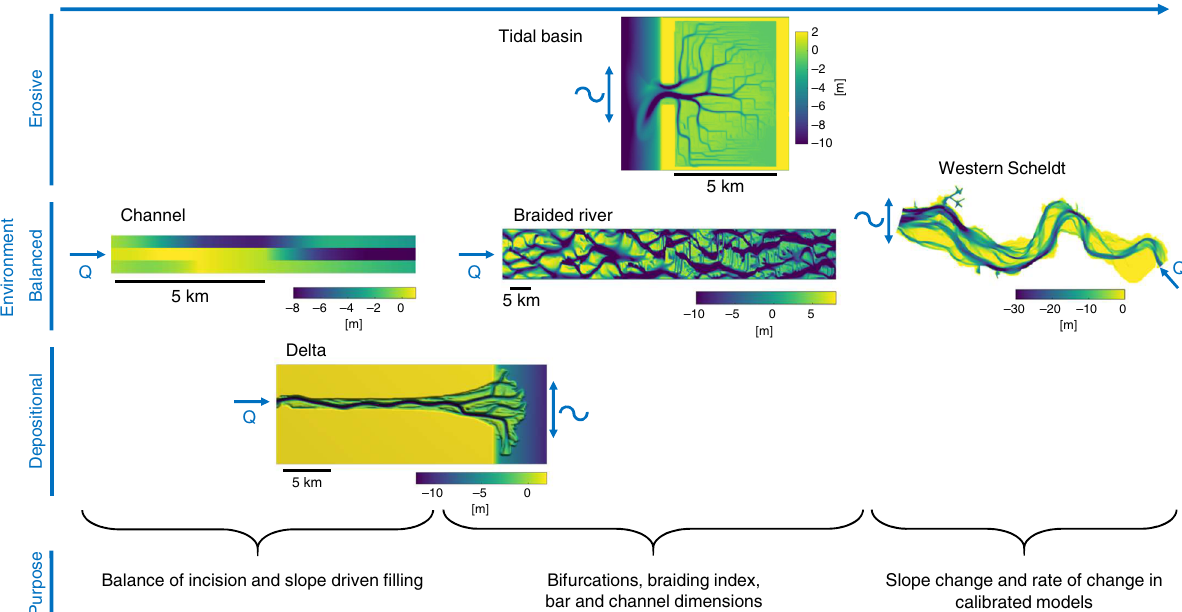
Fig. 3 Overview of model environments and objectives in this study. The narrow channel model and the river in the delta model are used to study local sediment transport processes. The delta model, the braided river model, and the tidal basin model quantify the effects of different slope parameterizations and magnitudes in combination with different sediment transport predictors on bifurcation dynamics, braiding index, and channel dimensions. The calibrated Western Scheldt estuary model shows differences in dynamics between models with different slope parameterizations and magnitudes relevant for fairway dredging depth and